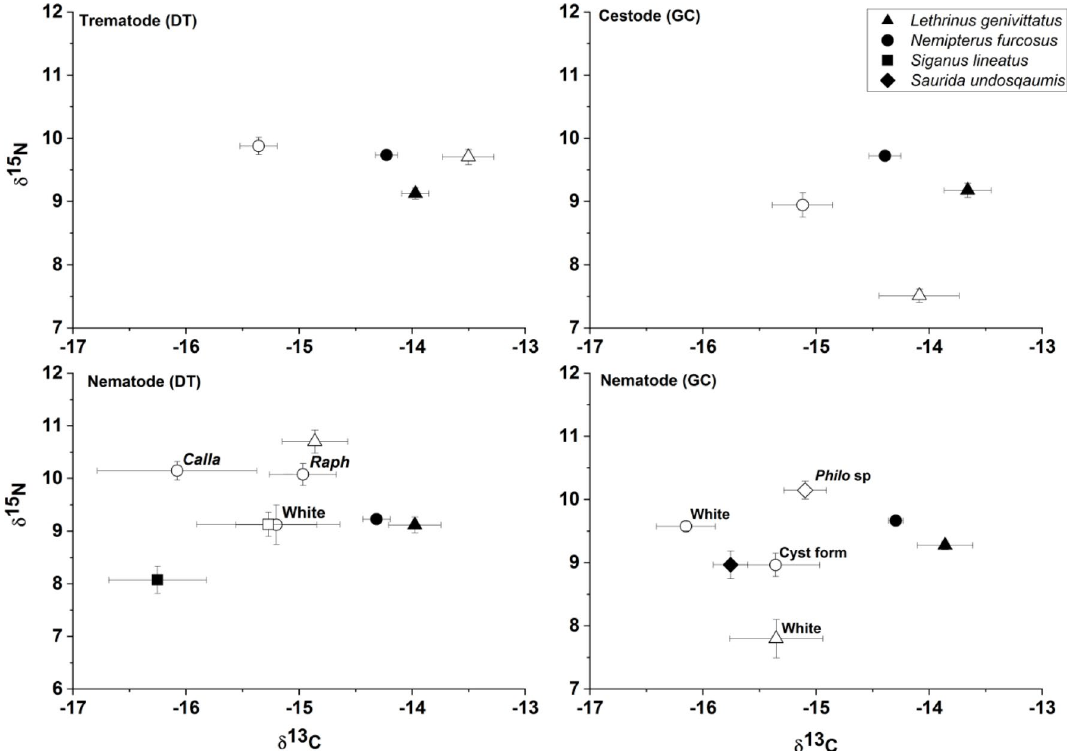
Figure 1. Mean δ 15 N and δ 13 C composition (± SD) for parasite and reef fish host pairings. Parasites and hosts are displayed with open and filled symbols, respectively. Dietary tract (DT) and general cavity (GC) refer to the parasite habitat within fish